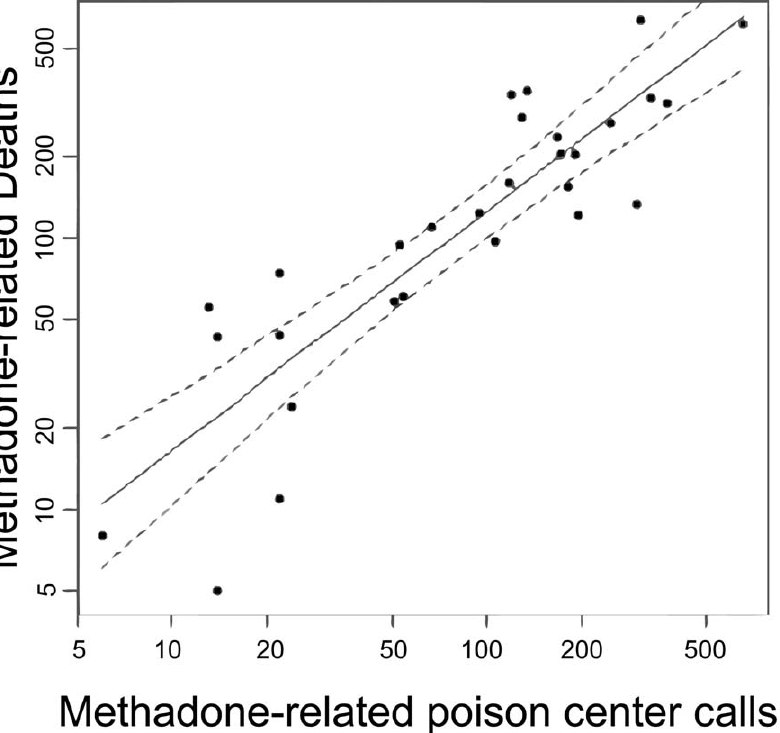
Figure 3. Poison center calls predict 77% of the variation in death counts from vital statistics data, 29 states, 2006–7. The plot shows the association between log-methadone death counts and log-methadone poison center calls; log scales are used for the sake of including all data on one graph since the state populations (and counts) vary widely. A strong association was found between poison center exposure calls and methadone-related mortality reported to vital statistics (b=0.88, SE=0.42, t=9.5, df=1, p , 0.0001, R 2 =0.77), where a one unit increase of poison center calls corresponded to a 0.88 unit increase in methadone related deaths. doi:10.1371/journal.pone.0041181.g003 PLoS ONE |